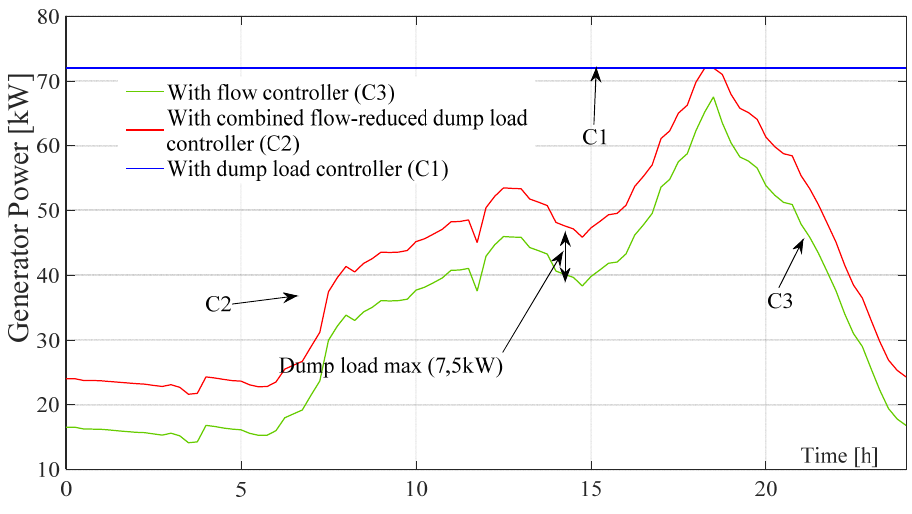
Figure 10. Daily power pattern for each controller.